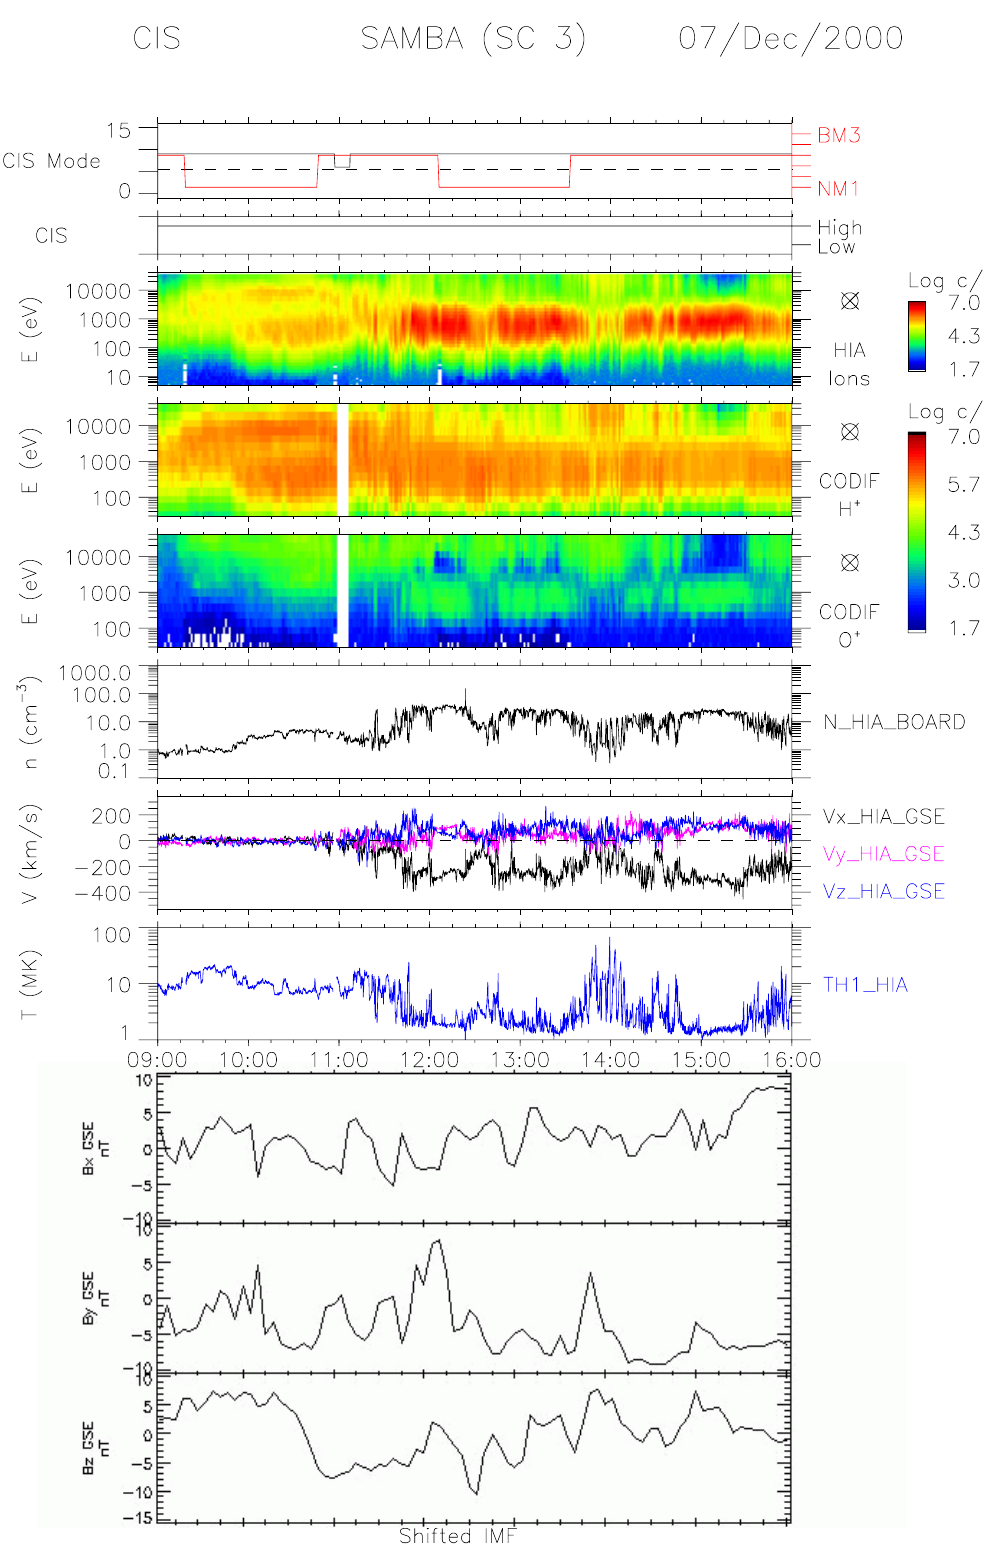
Fig. 27. 7 December 2000 magnetopause crossings between 09:00 and 16:00UT as seen by spacecraft 3; from top to bottom: Instrument modes, energy-time spectrograms of HIA ions, CODIF H + , and CODIF O + , HIA density, HIA velocity, and shifted IMF (from ACE, courtesy of N. Ness). The 1keV CODIF O + in the magnetosheath are instrument artifacts due to the contamination from high H + fluxes. The 10keV O + are true O +